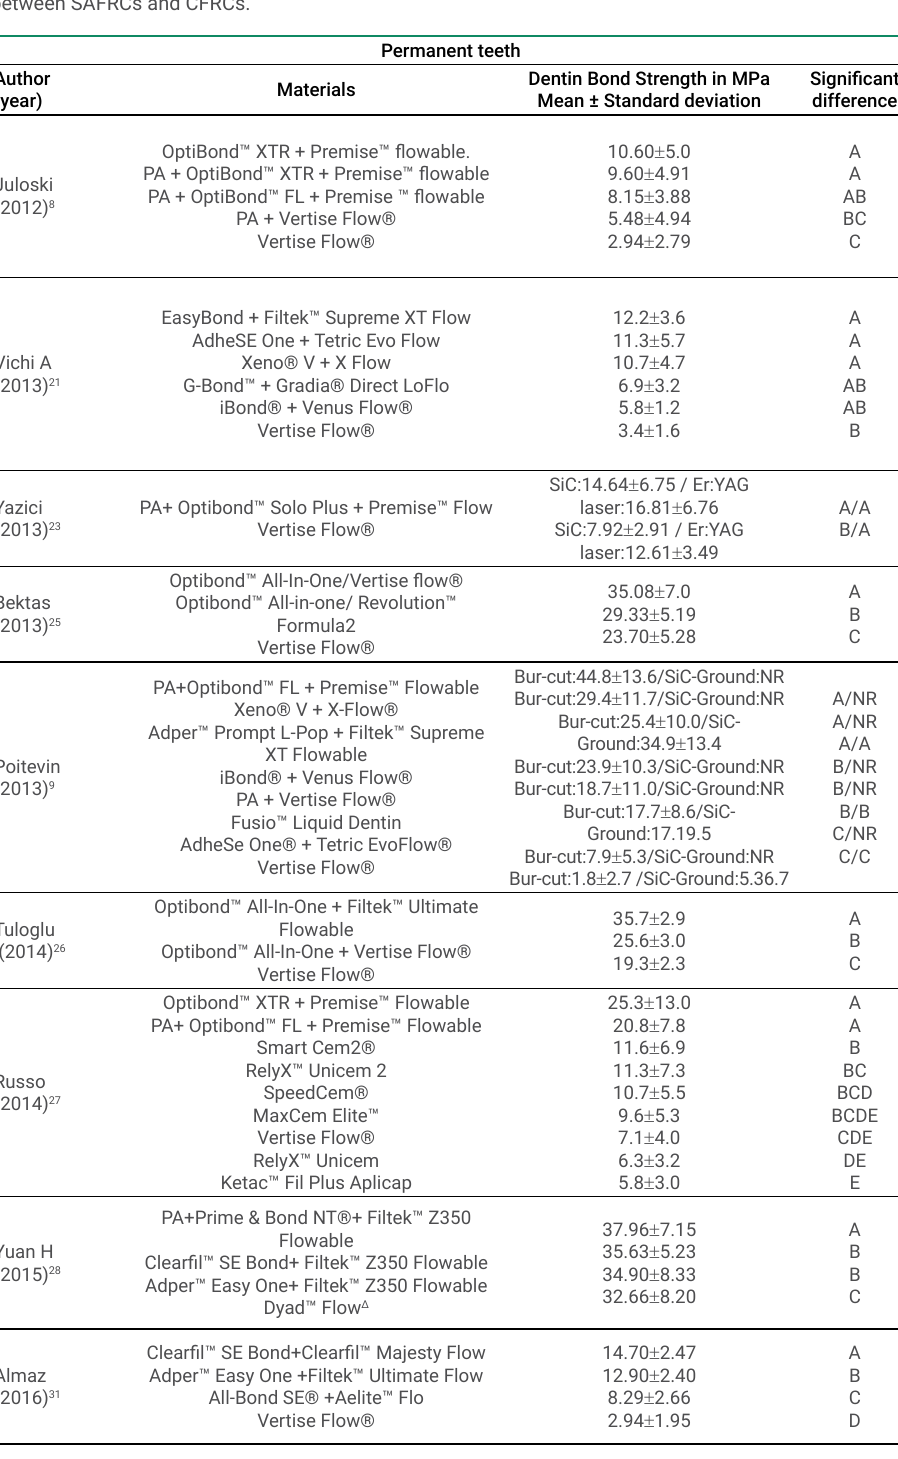
Table 4. Means, standard deviations and statistically significant differences on dentin bond strength between SAFRCs and CFRCs. Permanent